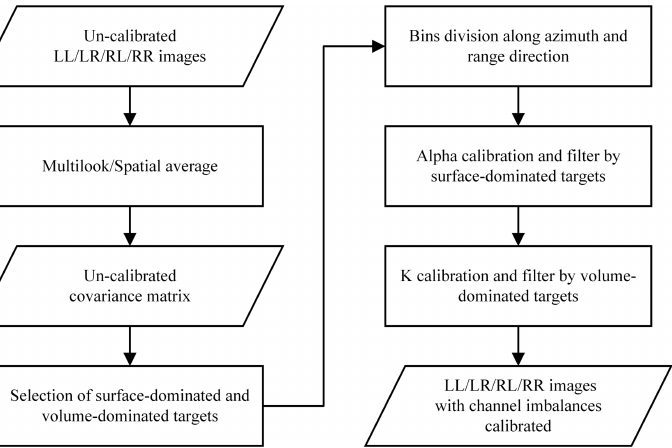
Figure 4. Channel imbalance calibration scheme for CQP SAR images with reciprocal